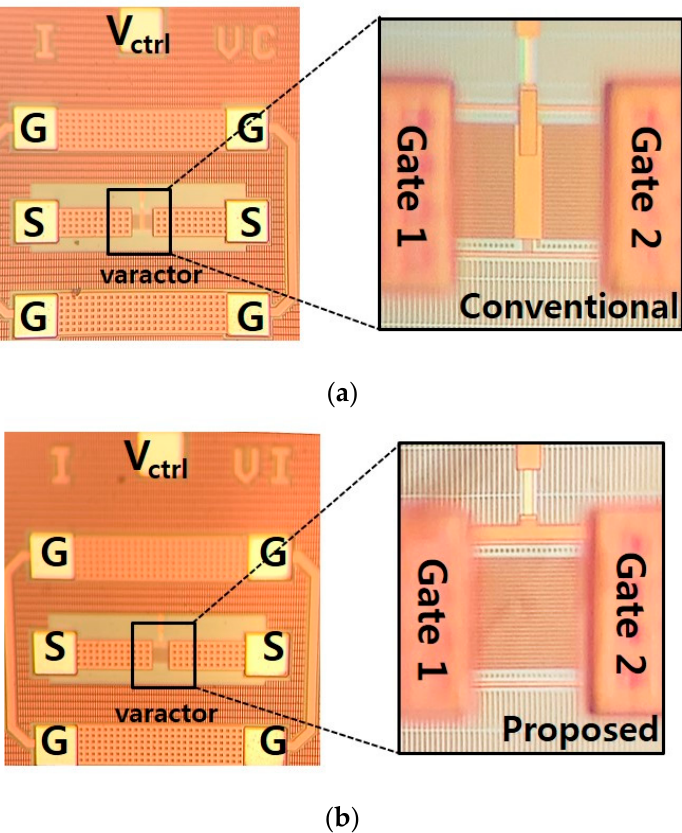
Figure 6. Chip photographs of the designed MOS varactors: ( a ) typical and ( b ) proposed struc- tures.